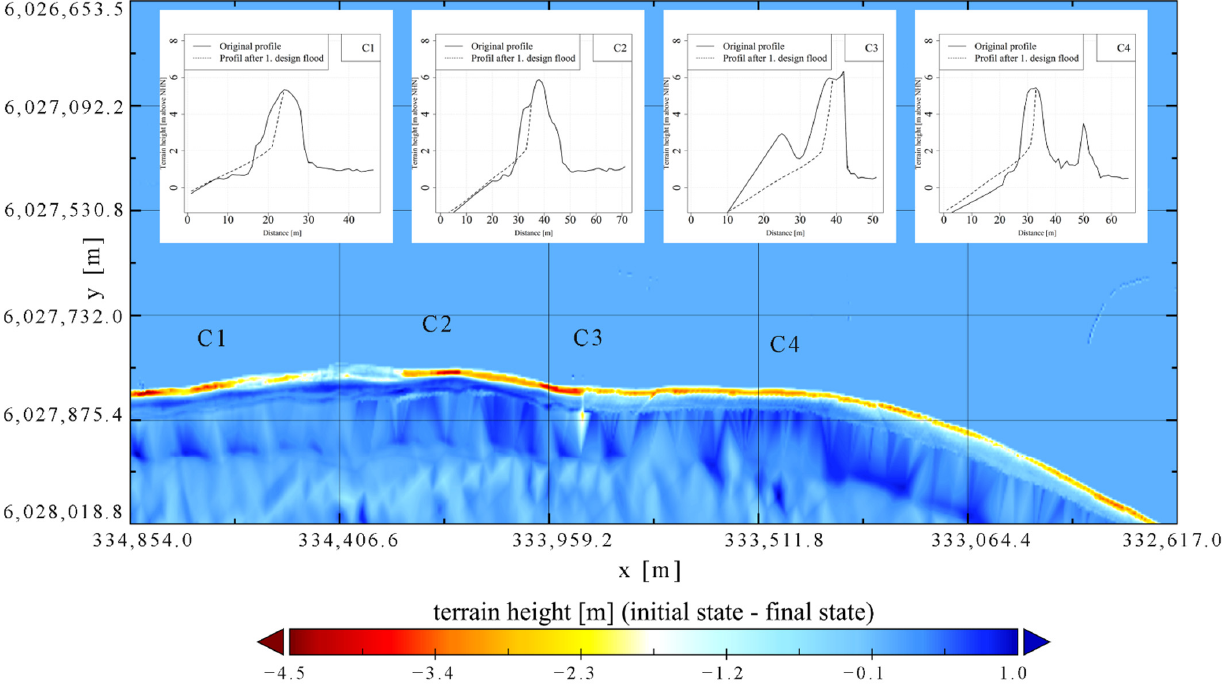
Figure 15. Critical erosion zones C1-C4 according to the XBeach model after the first load of the design flood.